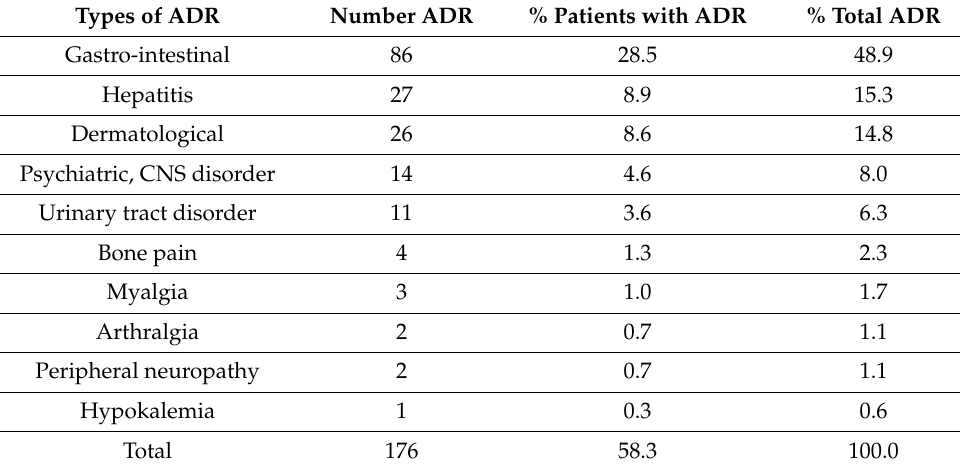
Table 8. Spectrum of adverse drug reactions among pediatric tuberculosis patients registered at Tashkent City Children Tuberculosis Hospital and Tashkent Regional Children Tuberculosis Hospital, Uzbekistan,